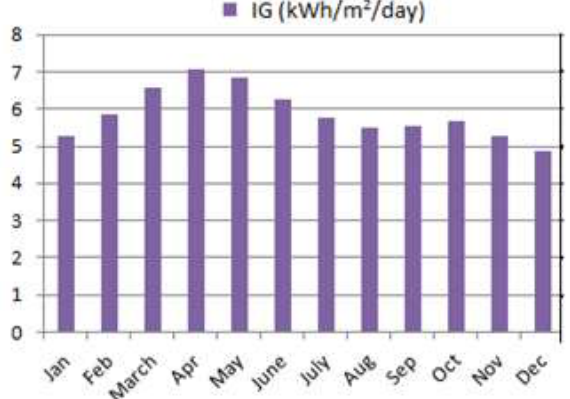
Figure 2: Annual variation of solar irradiation monthly average of the Bambey